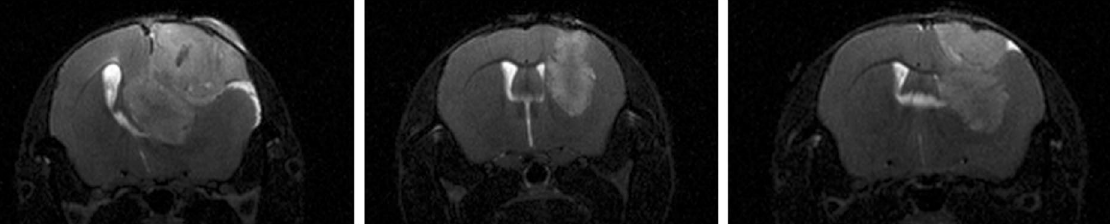
Figure 1. T2-weighted MR images taken 25 days after inoculation at the same location in the brain with respect to the initial needle track of the three mice used in this study. The left panel represents Mouse 1, the center, Mouse 2, and the right panel, Mouse 3. Despite inoculations with the same volume of tumor cells, the final tumors varied considerably in